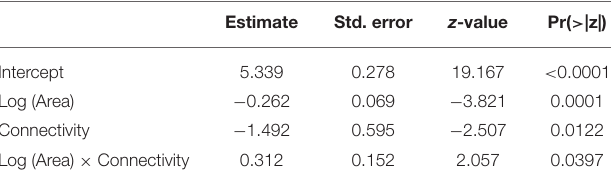
TABLE 5 | Parameter estimates and P- values for the GLM (Poisson distribution, log link function) built for total number of occurrences as a function of Log (Area), Connectivity and the interaction Log (Area) x